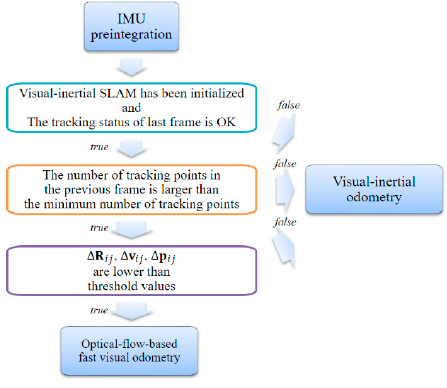
Figure 9. Flowchart of the adaptive execution module.